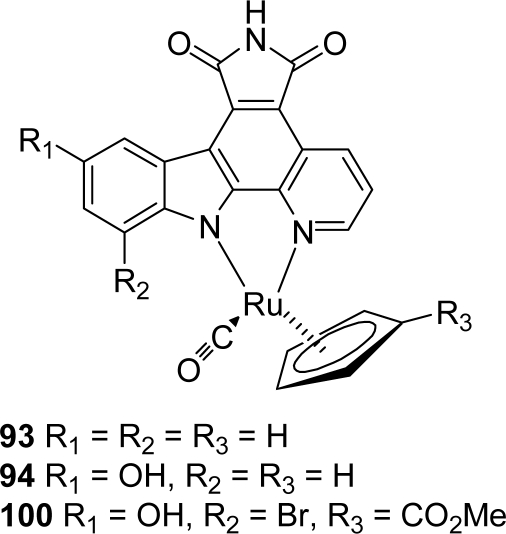
Pyridopyrrolocarbazole half-sandwich ruthenium complex.